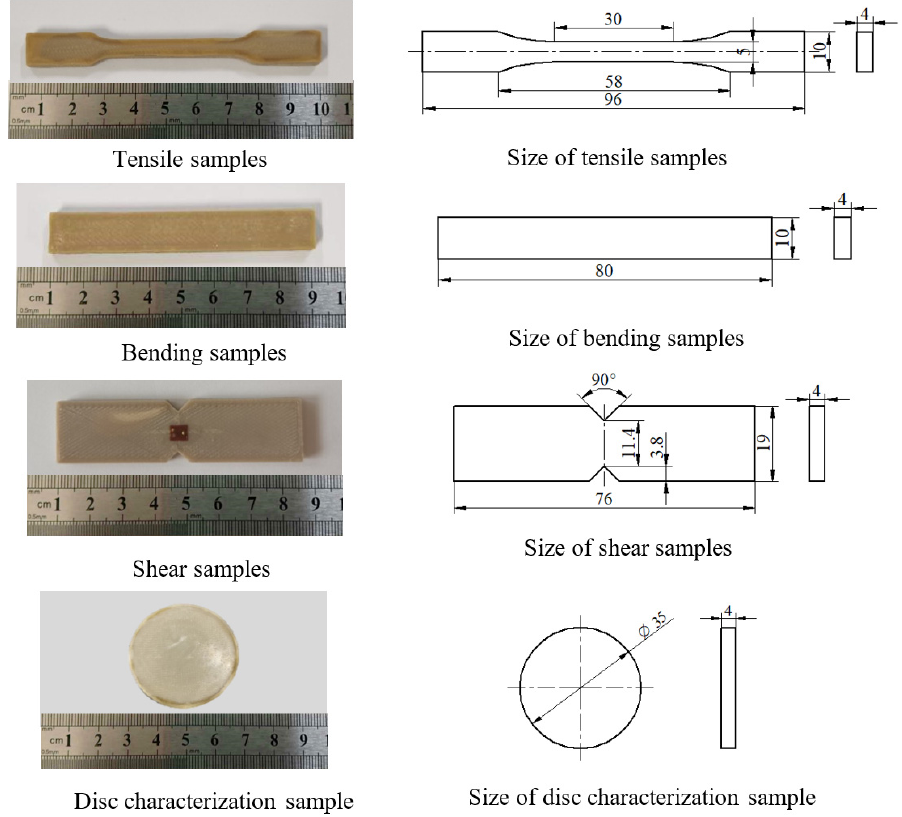
Figure 1. The shapes and dimensions of tensile samples, bending samples, shear samples, and disc characterization samples.